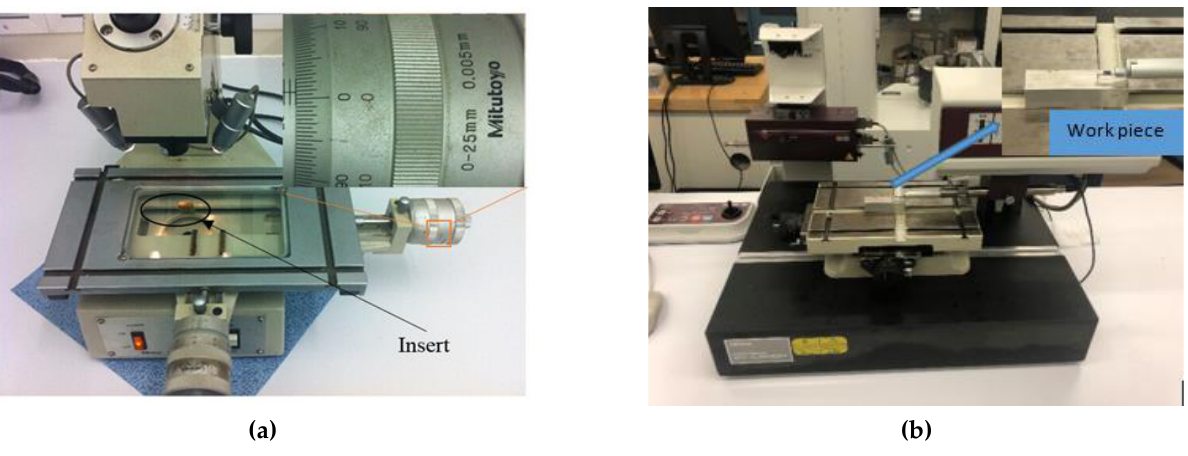
Figure 2. ( a ) Optical microscope and ( b ) Profilometer Mitutoyo SV-C4000.